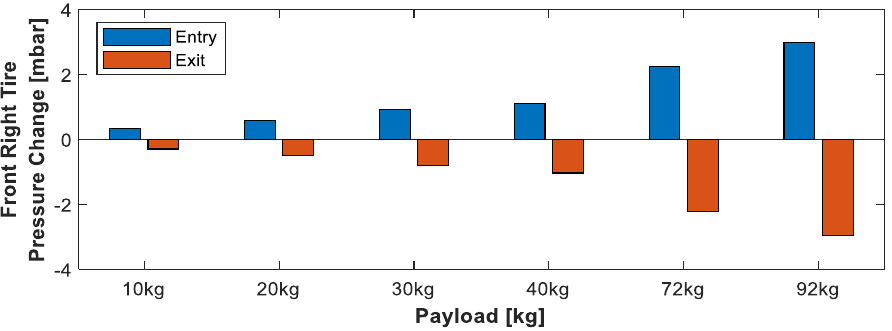
ff erent payloads